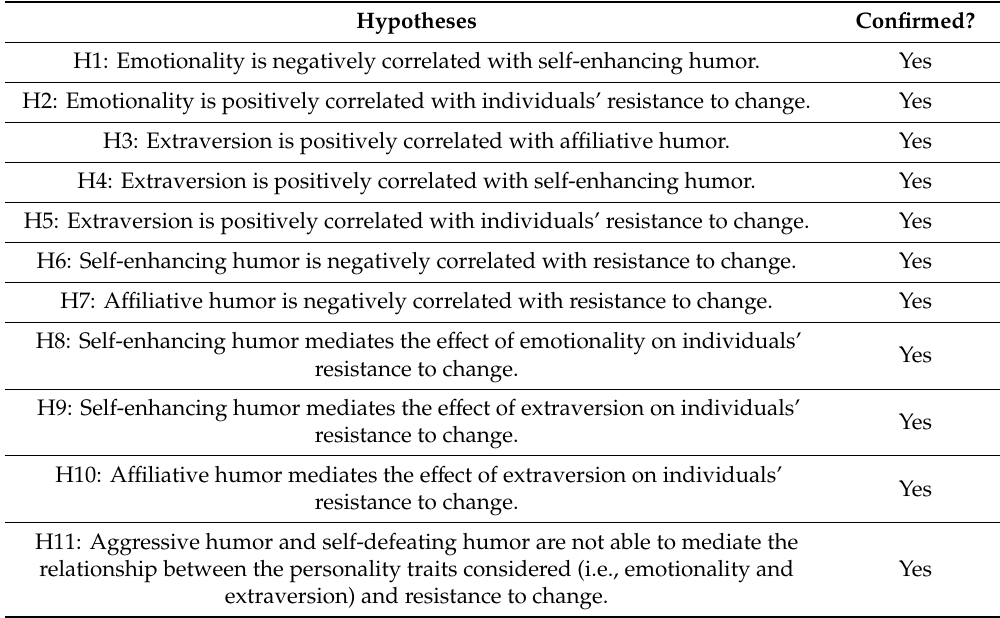
Table 9. Summary of the confirmed